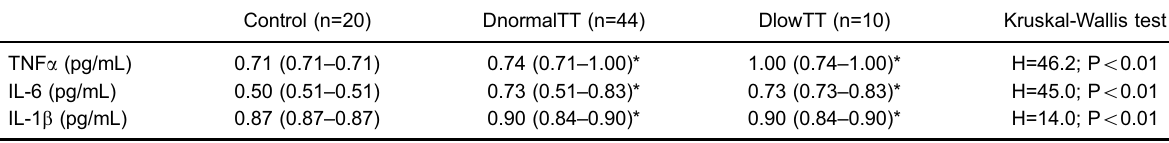
Table 3. Comparison of in fl ammatory markers tumor necrosis factor (TNF- a ), interleukin- 6 (IL-6), interleukin 1- beta (IL-1 b